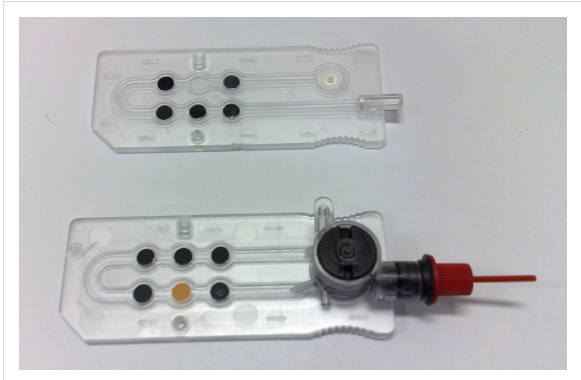
Figure 2: OPTI TM cassettes sold by Optimedical Inc. (http://www.opti- medical.com). Photograph is reprinted from [10], Copyright (2008) The Royal Society of